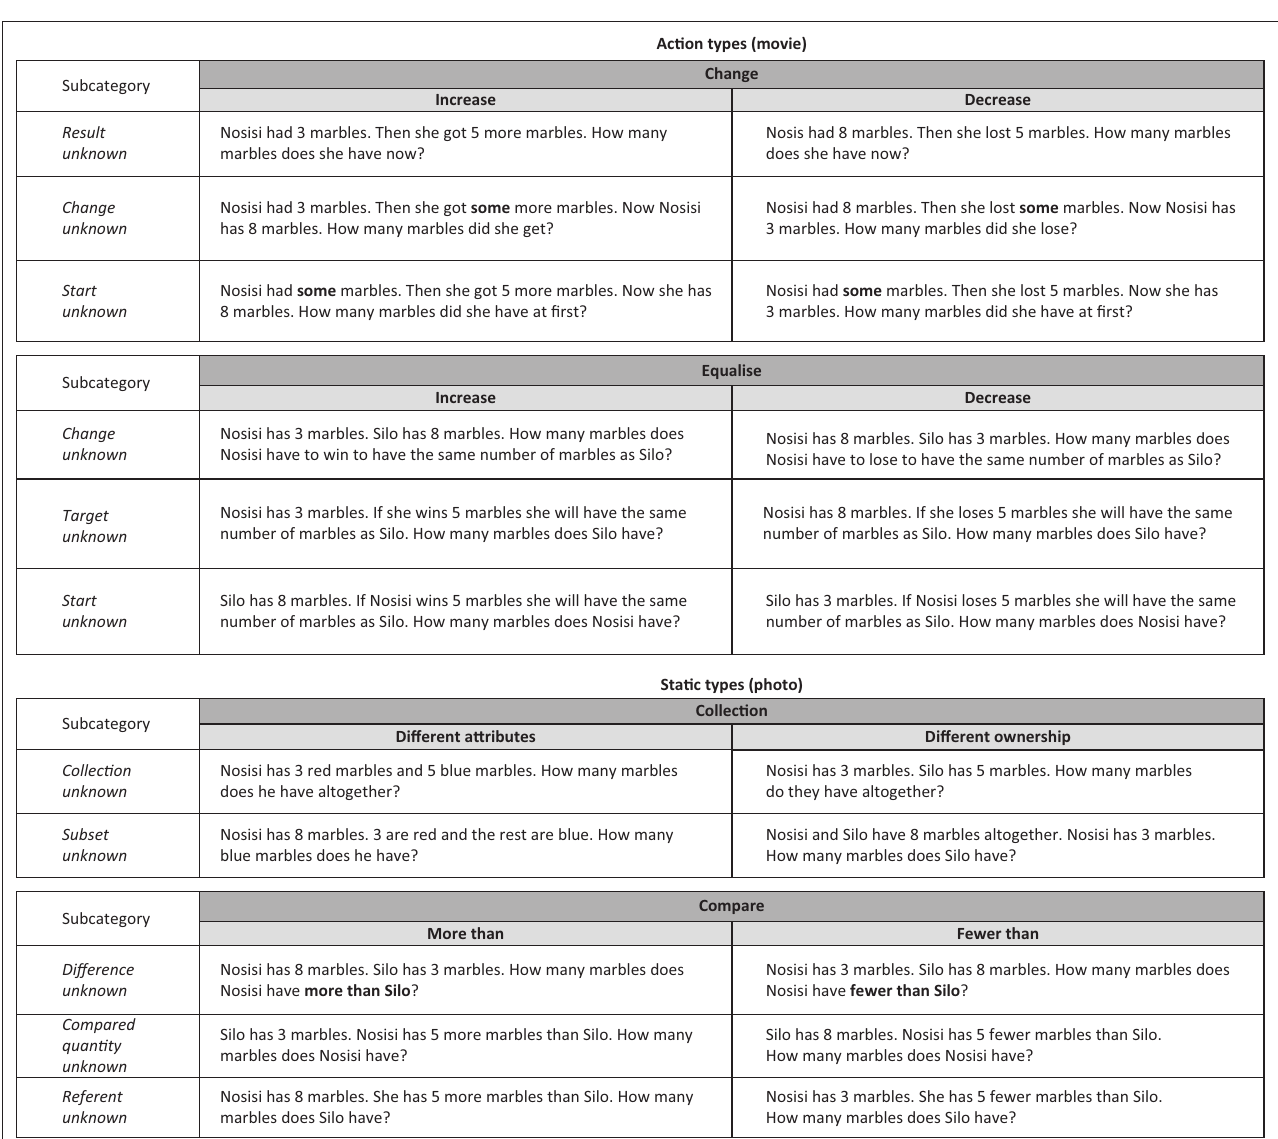
FIGURE 8: Compare-type problem with unknown referent made explicit.